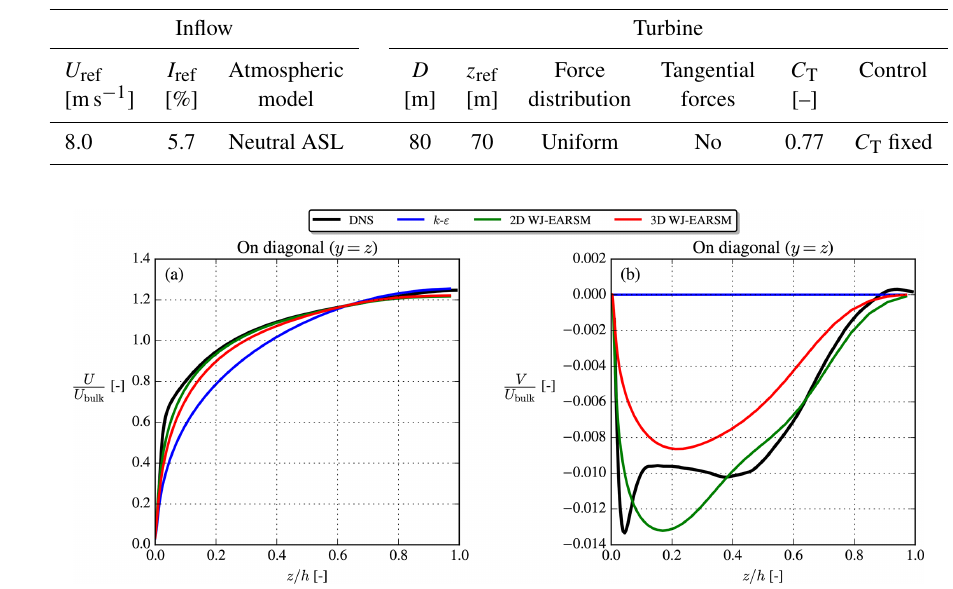
without the near-corner peak, which according to Pirozzoli Fig. 10. A grid convergence study was made to confirm